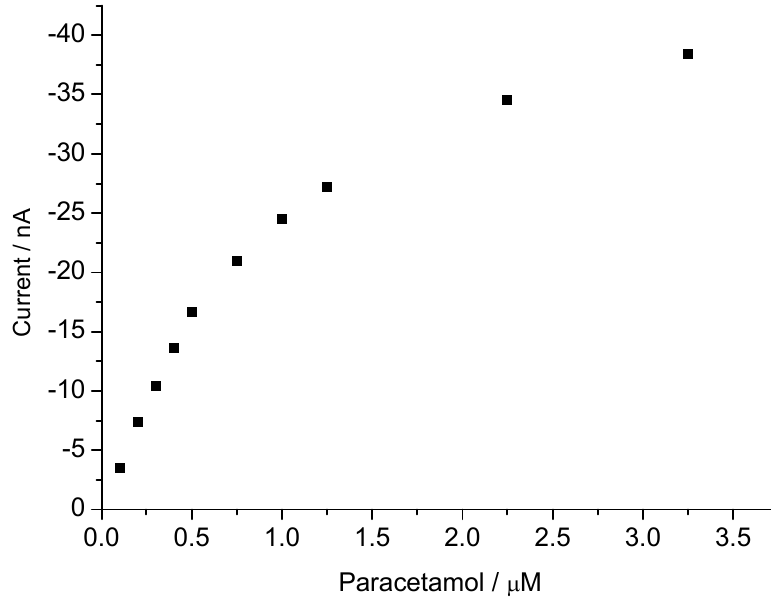
Figure 7. Concentration dependence for paracetamol at 0 V of the